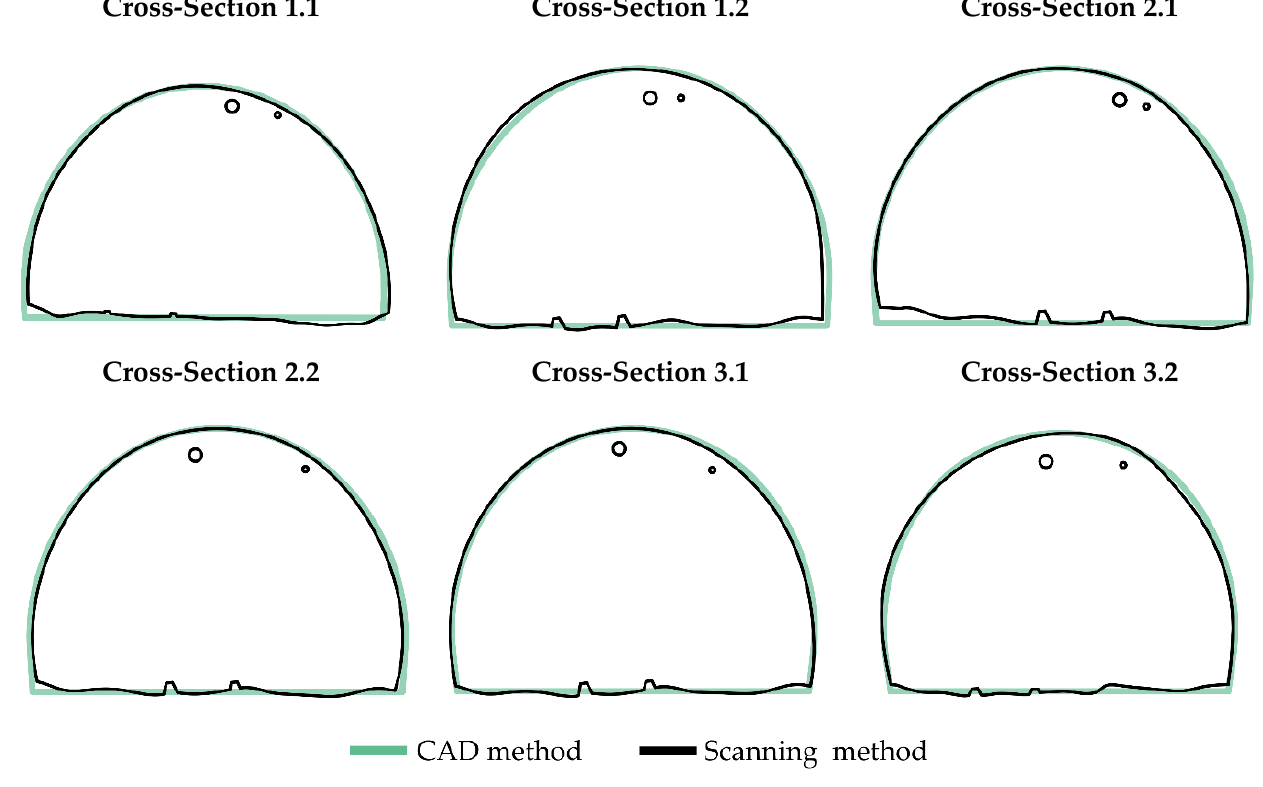
Figure 11. Reference cross-section outlines obtained by the laser scanning method presented on the cross-section outlines obtained by CAD method.